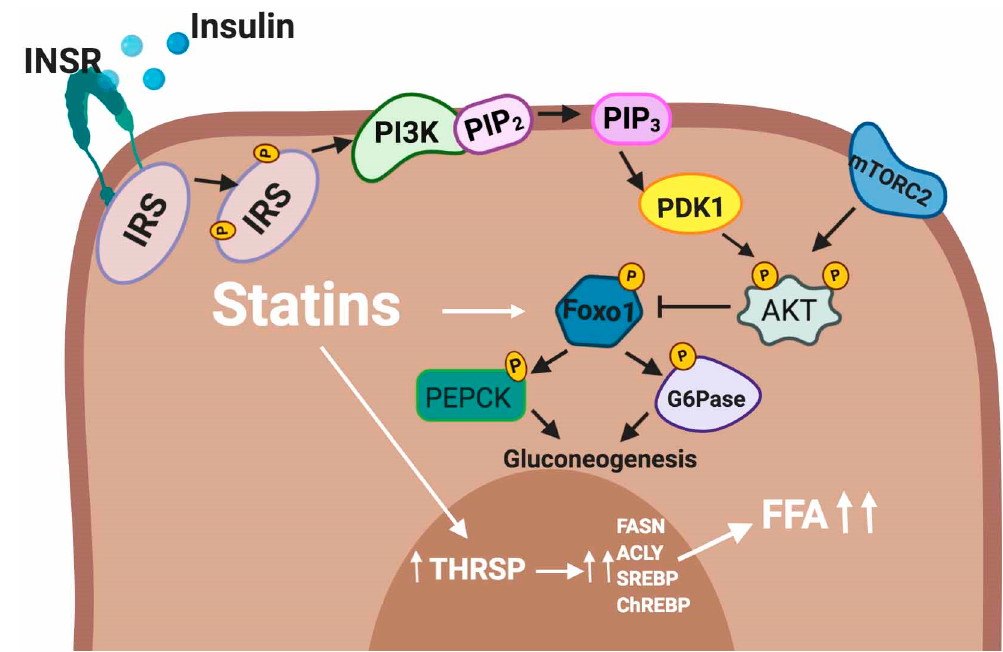
Figure 6. Intracellular actions of statins in hepatocytes. White lines indicate the mechanisms affected by statins.